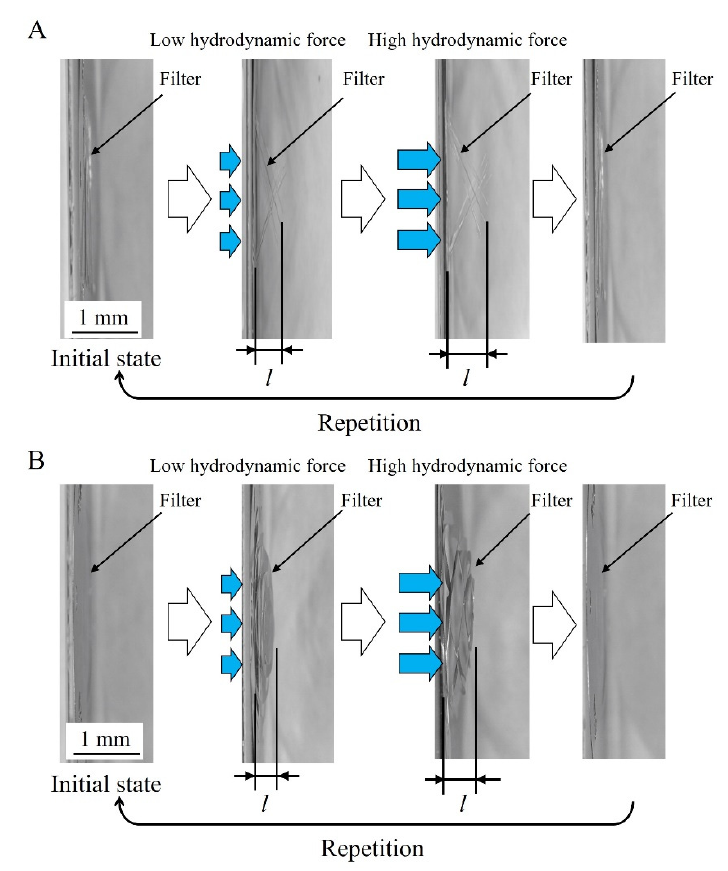
Figure 12. Photographs of three-dimensionally deformable metal structures. Type A is comb-shaped, and Type B is a metal structure with multiple arc-shaped slits. The deformation quantity l changes with the magnitude of the hydrodynamic force. When the hydrodynamic force is unloaded, the struc- ture returns to its original state. The deformation of the Type A structure at a flow rate of 300 mL/h was approximately 110 µm, and that at a flow rate of 2400 mL/h was approximately 820 µm. The deformation of the Type B structure at a flow rate of 300 mL/h was approximately 40 µm, and that at a flow rate of 2400 mL/h was approximately 90 µm. The deformations of both structures increased linearly with increasing flow rate. In addition, a comparison of the simulated and measured defor- mation of the two metal structures under a flow rate of 300 mL/h revealed that Type A showed defor- mation of approximately 120 µm (simulation value), and the measurement result was 110 µm, while Type B showed deformation of approximately 40 µm (simulation value), and the measurement result was 40 µm. Under low flow-rate conditions, the simulated and measured results showed good agree- ment (Supplementary Materials Figure S2). There was no plastic deformation, even under conditions with a flow rate of 2400 mL/h. As there were no realistic conditions for exceeding 2400 mL/h, it was not possible to verify until plastic deformation occurred. In this study, as a limitation to elastic defor- mation, results were shown for conditions with a flow rate of 300–2400 mL/h. Figure 13 shows a cross-sectional scanning-electron microscopy (SEM) image of a Type B metal structure fabricated using 10 µm and 2 µm as the target film thicknesses for Ni electroforming and Au plating, respectively. Type B is obtained with Au coating from the basic baths in Table 2. The digital microscopy and cross-sectional SEM images show that there are no pinholes or cracks on the surface of the metal structure, demonstrating the absence of structural defects. The Ni electroforming thickness is 10.1 µm, the Au-plat- ing thickness is 2 µm, and the film thickness can be formed as designed. In addition, a structure with a high aspect ratio (film thickness/slit width = 3.9) could be fabricated with good precision using this process. Incidentally, the yield of the fabricated structure is 90%. The three-dimensionally deformable microstructure fabricated using the process devel-